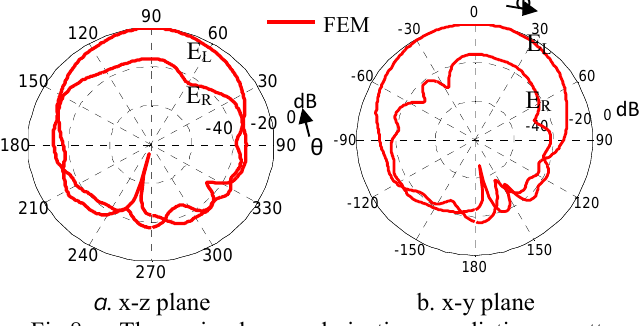
Fig.8. The circular polarization radiation pattern components of the circularly polarized DRA element mounted on a cylindrical ground plane placed inside a reader device and with the human hand model, at f=5.8 GHz.